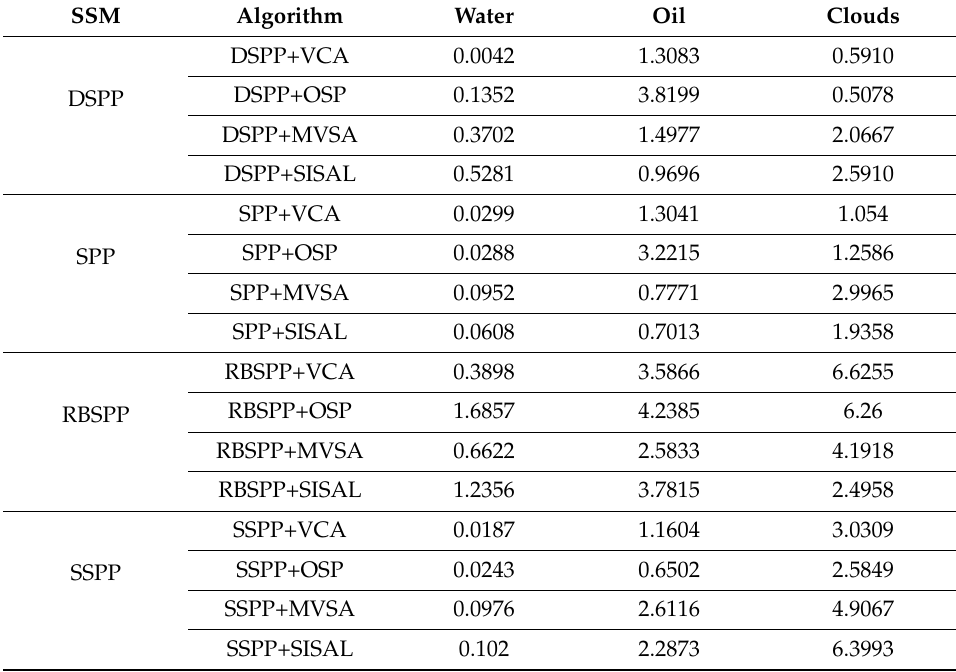
Table 4. SSM value of endmembers using several different algorithms.